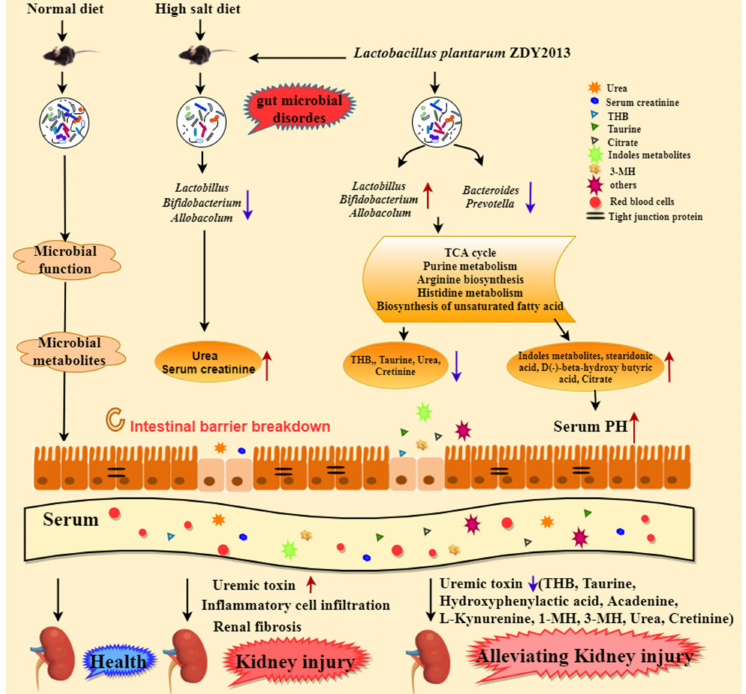
Figure 5. Mechanism figure of Lactobacillus plantarum ZDY2013 in alleviating renal injury induced by high-salt diet. The blue downward arrow indicates a decrease in relative abundance or metabolite concentration, while the red upward arrow indicates an increase in relative abundance or metabolite concentration. Different shaped species represent different metabolites, proteins, or cells,